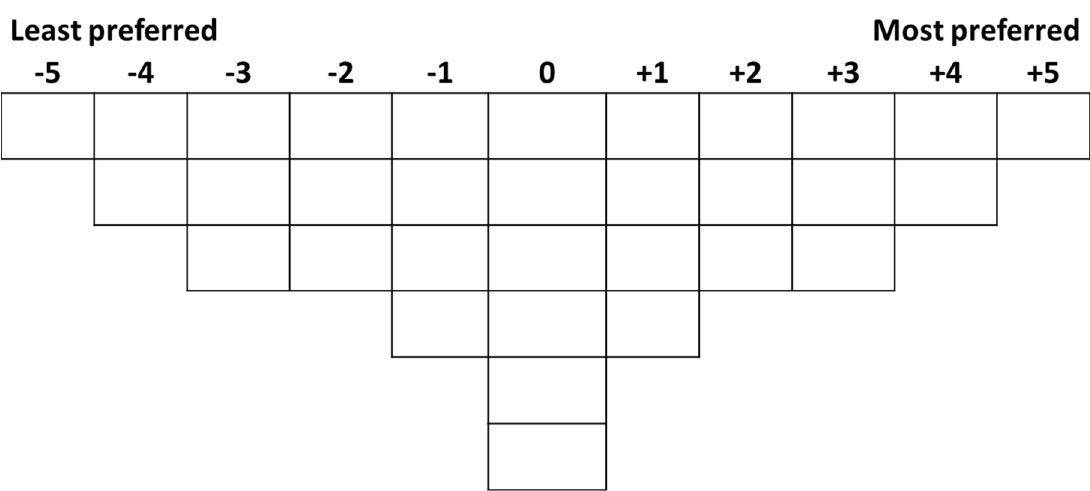
Figure 3. The response grid of Q-sorting procedure.